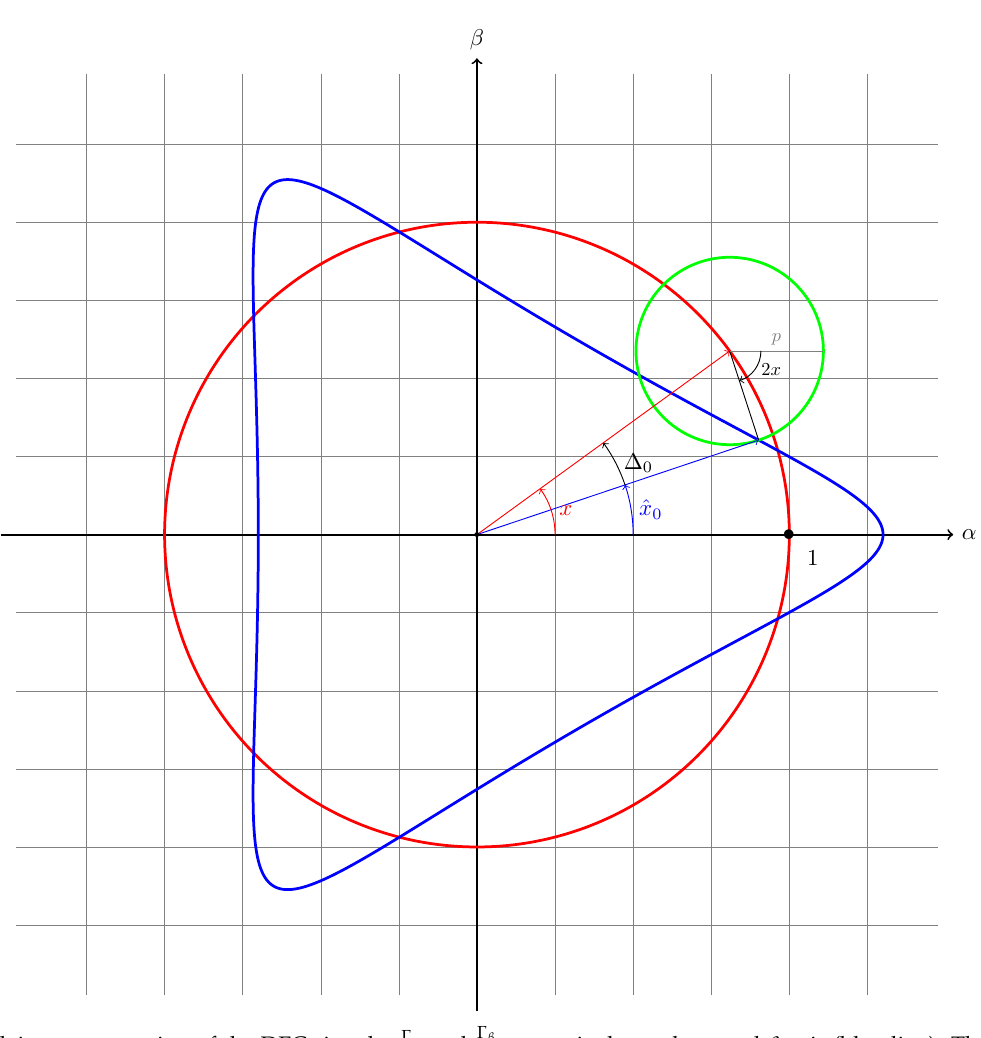
Figure 4. Plain representation of the DFC signals: represents the signals for the case b = 0 and is taken as reference. The green circle with radius p represents the term related to sin ( 2 x ) and cos ( 2 x ) (for this case p =